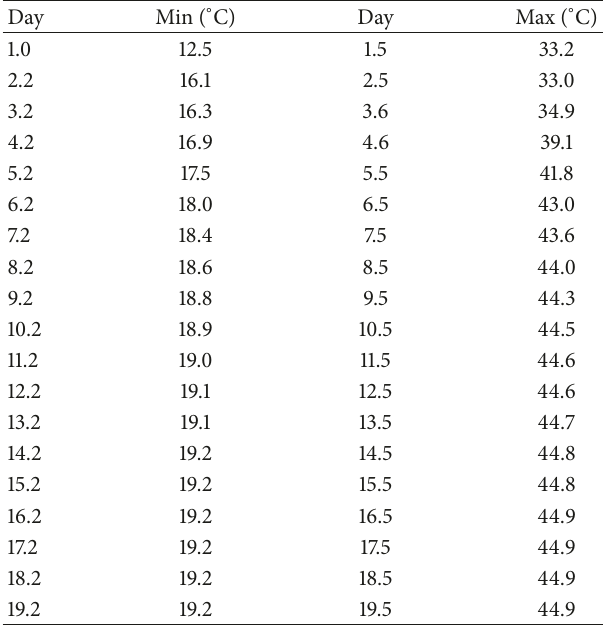
Table 4: Maximum and minimum values of soil temperature and the corresponding time